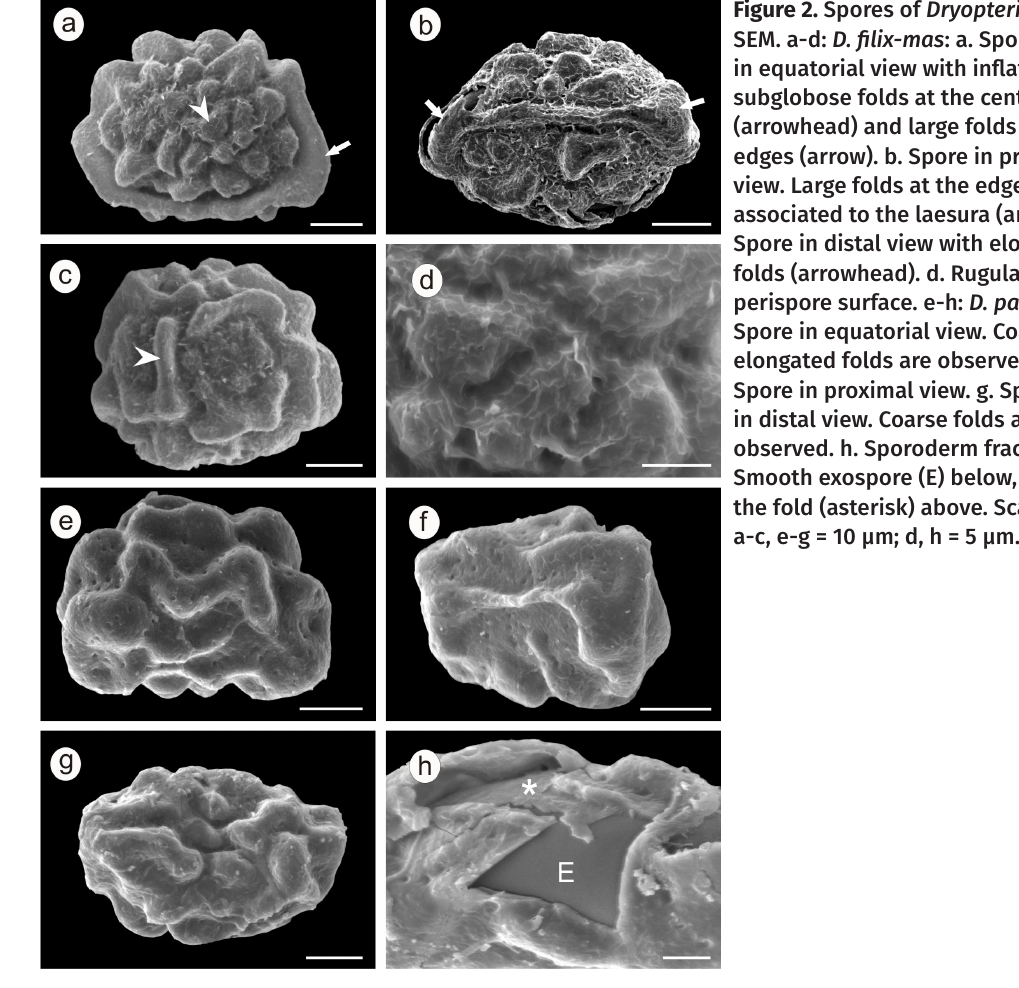
Figure 2. Spores of Dryopteris with SEM. a-d: D. filix-mas : a. Spore in equatorial view with inflated, subglobose folds at the center (arrowhead) and large folds at the edges (arrow). b. Spore in proximal view. Large folds at the edge are associated to the laesura (arrows). c. Spore in distal view with elongated folds (arrowhead). d. Rugulate perispore surface. e-h: D. patula e. Spore in equatorial view. Coarse, elongated folds are observed. f. Spore in proximal view. g. Spore in distal view. Coarse folds are observed. h. Sporoderm fracture. Smooth exospore (E) below, base of the fold (asterisk) above. Scale bars: a-c, e-g = 10 µm; d, h = 5